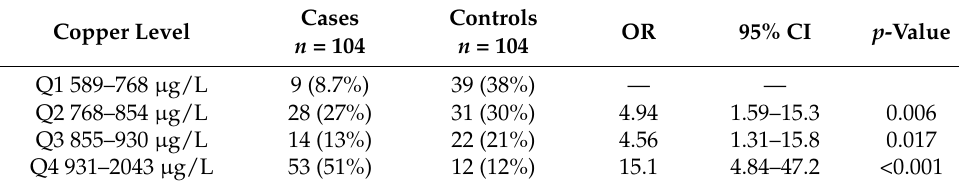
Table 4. Blood copper levels and the occurrence of colorectal cancer among